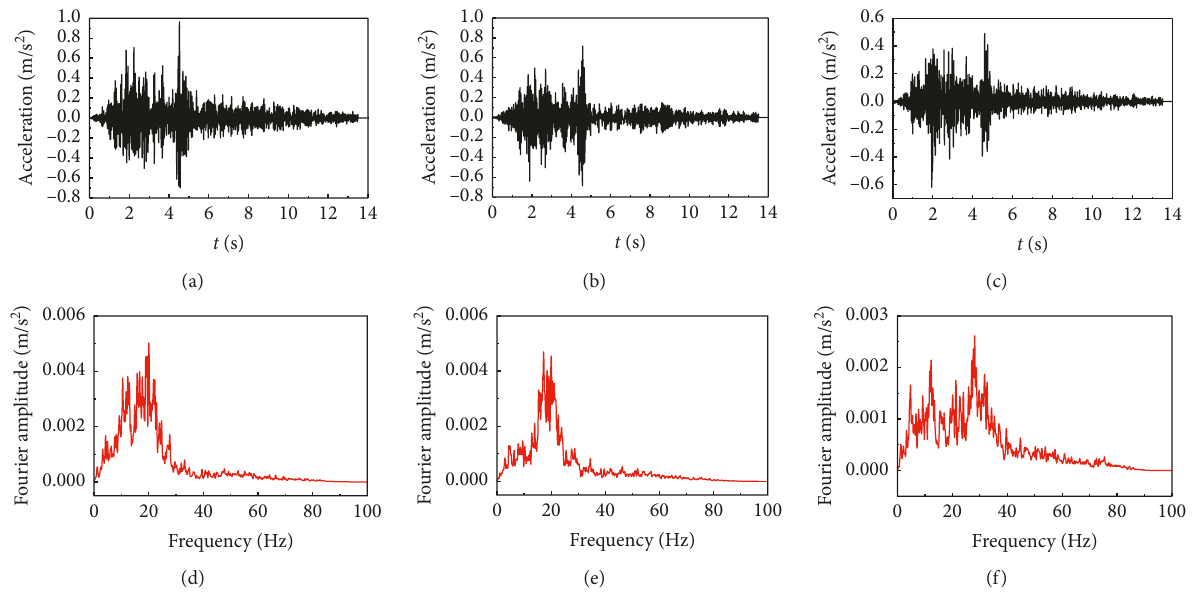
Figure 7: Details of the Lsfx seismic motion. (a) Time history curve in x direction; (b) time history curve in y direction; (c) time history curve in z direction; (d) Fourier spectra in x direction; (e) Fourier spectra in y direction; (f) Fourier spectra in z direction. Table 7: Details of the Fourier amplitude of the three seismic motions before the application of the isolated supports. Seismic